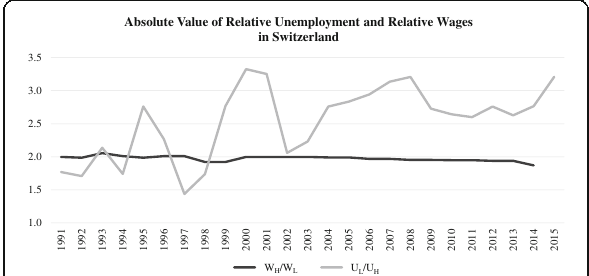
Fig. 1 Evolution of relative wages and relative unemployment in Switzerland. Source: Own calculations based on FOS (2008), Wyss (2010) FOS (2016a,